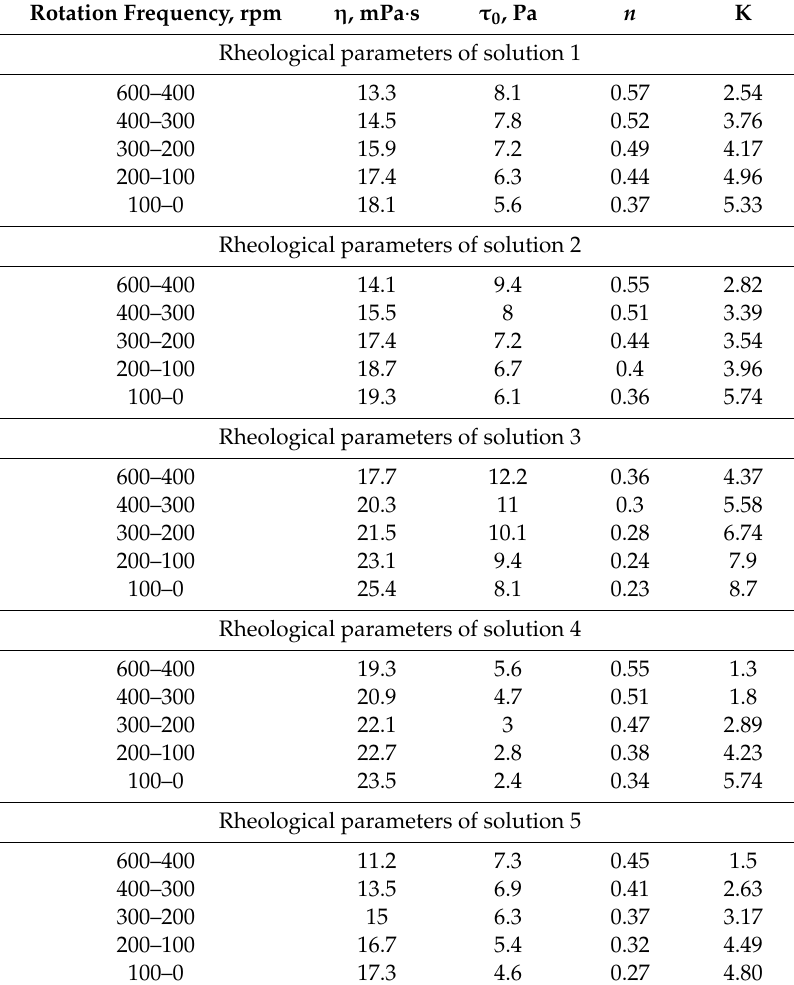
Table 5. Rheological parameters of investigated